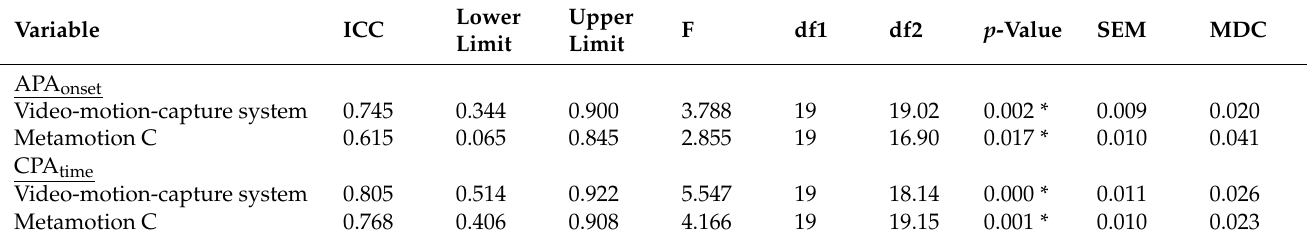
Table 1. The intra-session intraclass correlation coefficient (ICC) of all analyzed variables and the two instruments used, where the asterisk (*) represents the values that obtained statistical significance ( p ≤